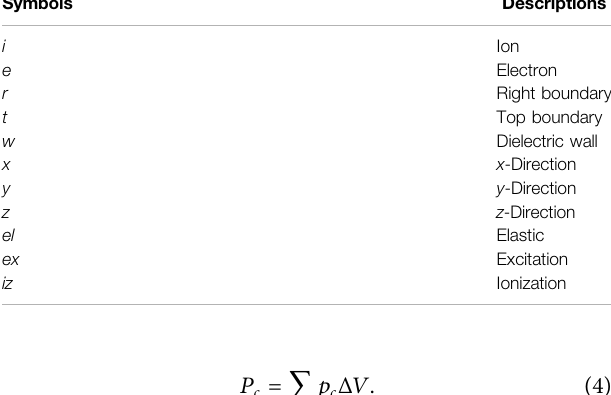
TABLE 2 | Subscripts of energy losses.